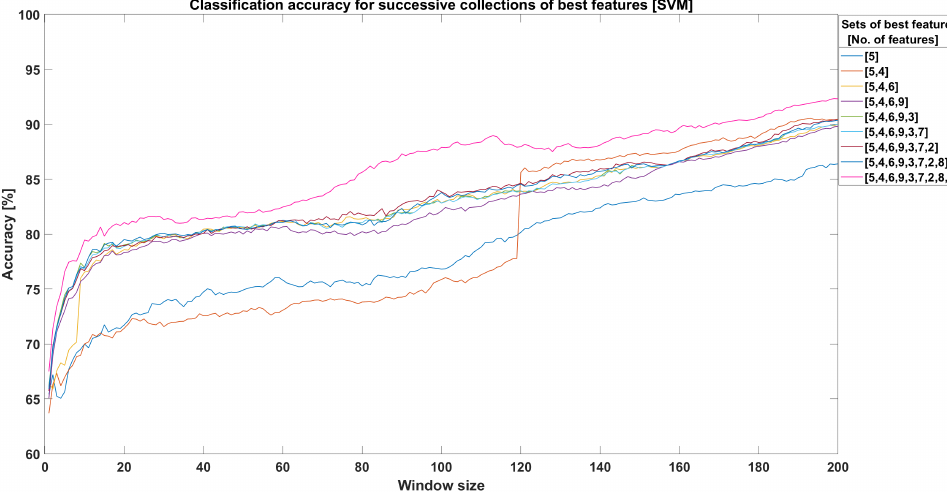
Figure 11. Classification accuracy for successive collections of best features